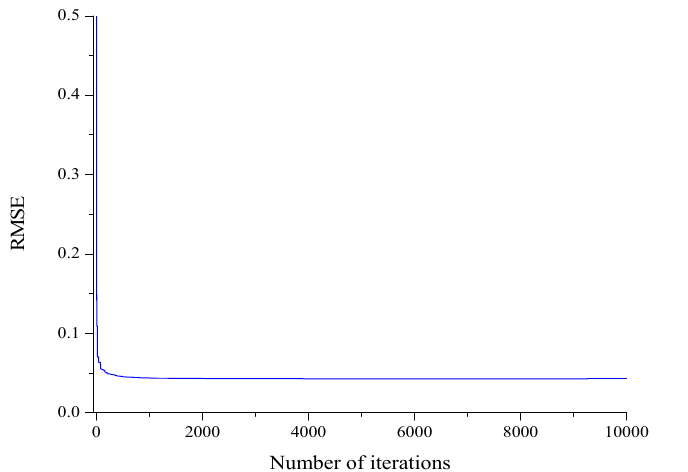
Figure 19. P–V curves for the double-diode practical system at different irradiance and temperature levels.